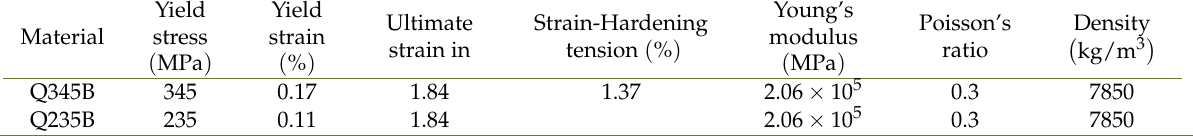
Table 2. Mechanical Properties of Q345B and Q235B